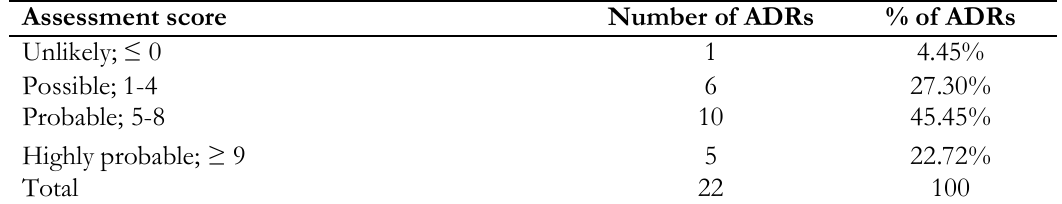
Table V Classification of 22 cases of ADRs according to Naranjo’s ADR probability scale Assessment